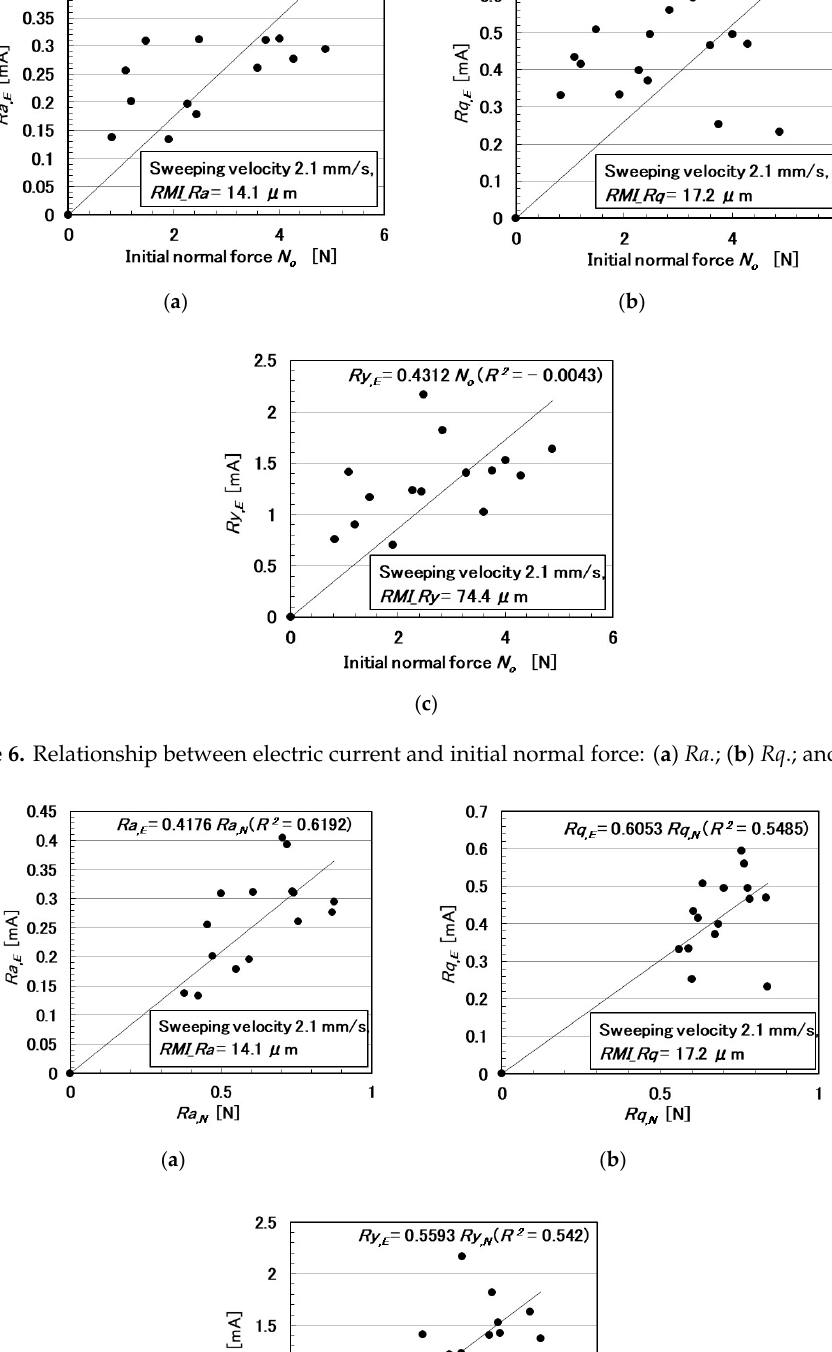
Figure 5. Relationship between electric current and surface roughness: ( a ) Ra .; ( b ) Rq .; and ( c ) Ry .